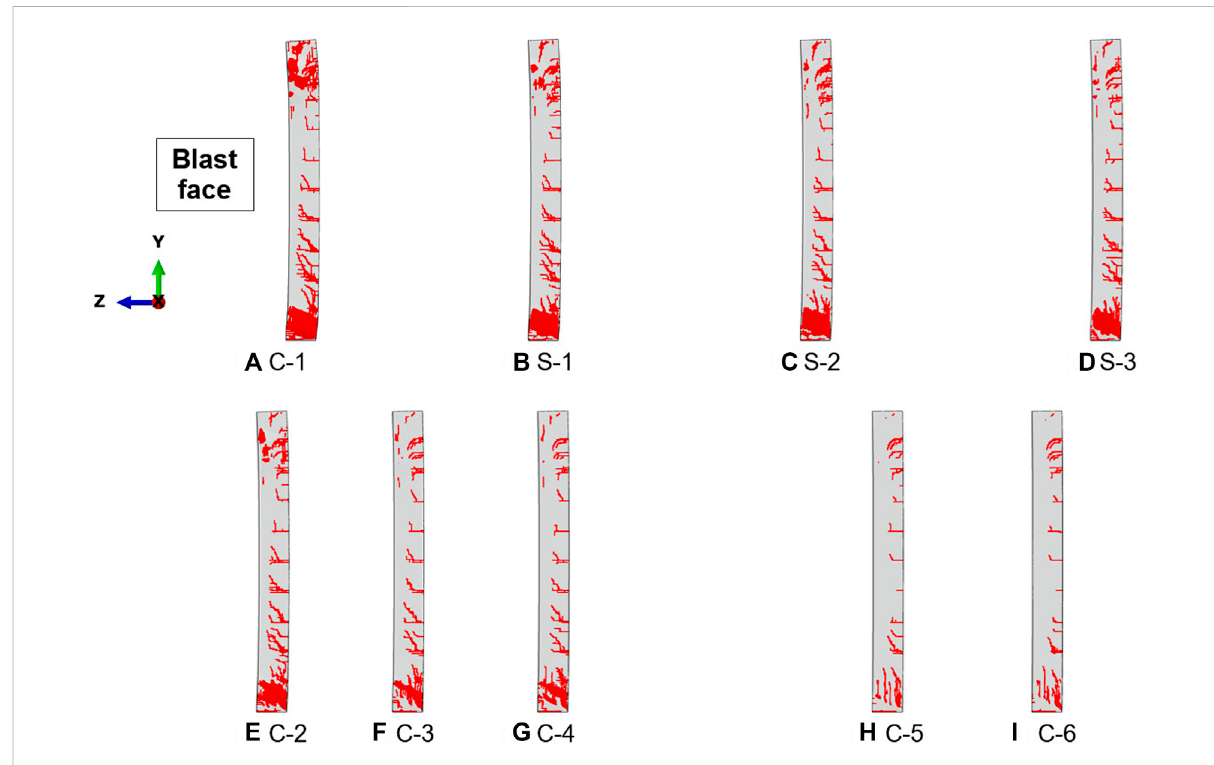
FIGURE 8 Pro fi le of cracking and spalling of the concrete of the columns.